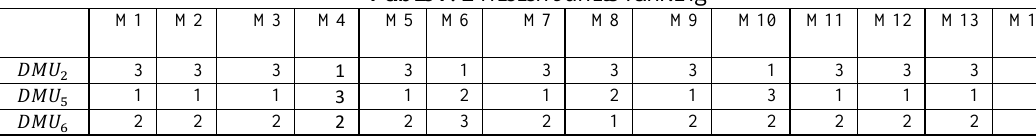
Table4 . Efficient units